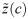
Signalling cost functions, depending on offspring condition c and parental transfer z.(A) equilibrium signal cost (f(x*(c))) for the different cost functions (Eqs 13, 17 and 19). (B) Signal cost function L1 (Eq 12). (C) Linear combination ½ L1 + ½ L2 (Eq 18) (D) signal cost function L2 introduced in this paper (Eq 16). Red, green and orange curves show the signal cost (f(x*(c))) along the equilibrium path (which describes the equilibrium transfer function z˜(c) for parent as a function of c); panel A shows these curves projected to the c-f(c) plane. (E) Partial derivatives of the signal cost functions L1, L2 and their linear combination, with respect to z along the equilibrium path as a function of c. (F) Partial derivative of signal cost function L1 (Eq 12) with respect to z. (G) Partial derivative of the linear combination ½ L1 + ½ L2 (Eq 18) (H) Partial derivative of signal cost function L2 introduced in this paper (Eq 16) with respect to z. Red, green and orange curves show the partial derivatives of the respective signal cost functions along the equilibrium path with respect to z; panel E shows these curves projected to the c-f(c) plane. Parameters are Z = 10, G = 0.08, U = 1, γ = ½, ψ = ½.